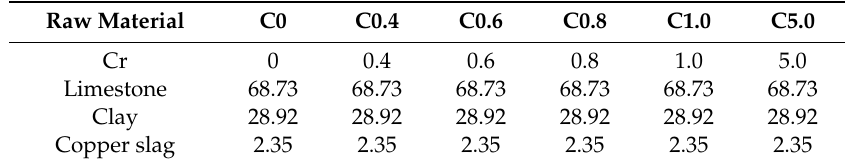
Table 2. Raw material ratio / wt